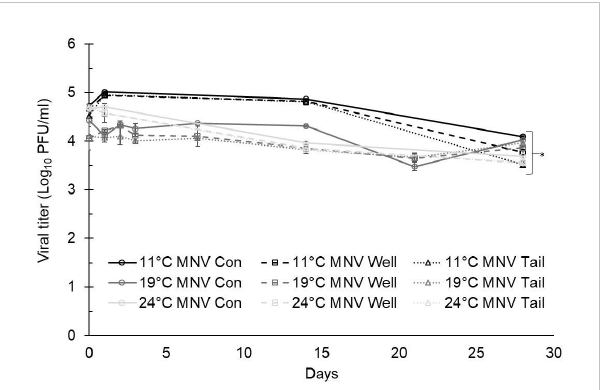
FIGURE 2 Murine norovirus (MNV) infectivity in ultrapure (control), well, and tail water samples held at 11, 19, and 24°C and assessed for 28 days. Viral titer is reported as PFU/ml. Data points are the average of six replicates. Error bars represent ± standard deviation. * denotes signi fi cant difference (p<0.05) compared to day 0 within the same treatment group.